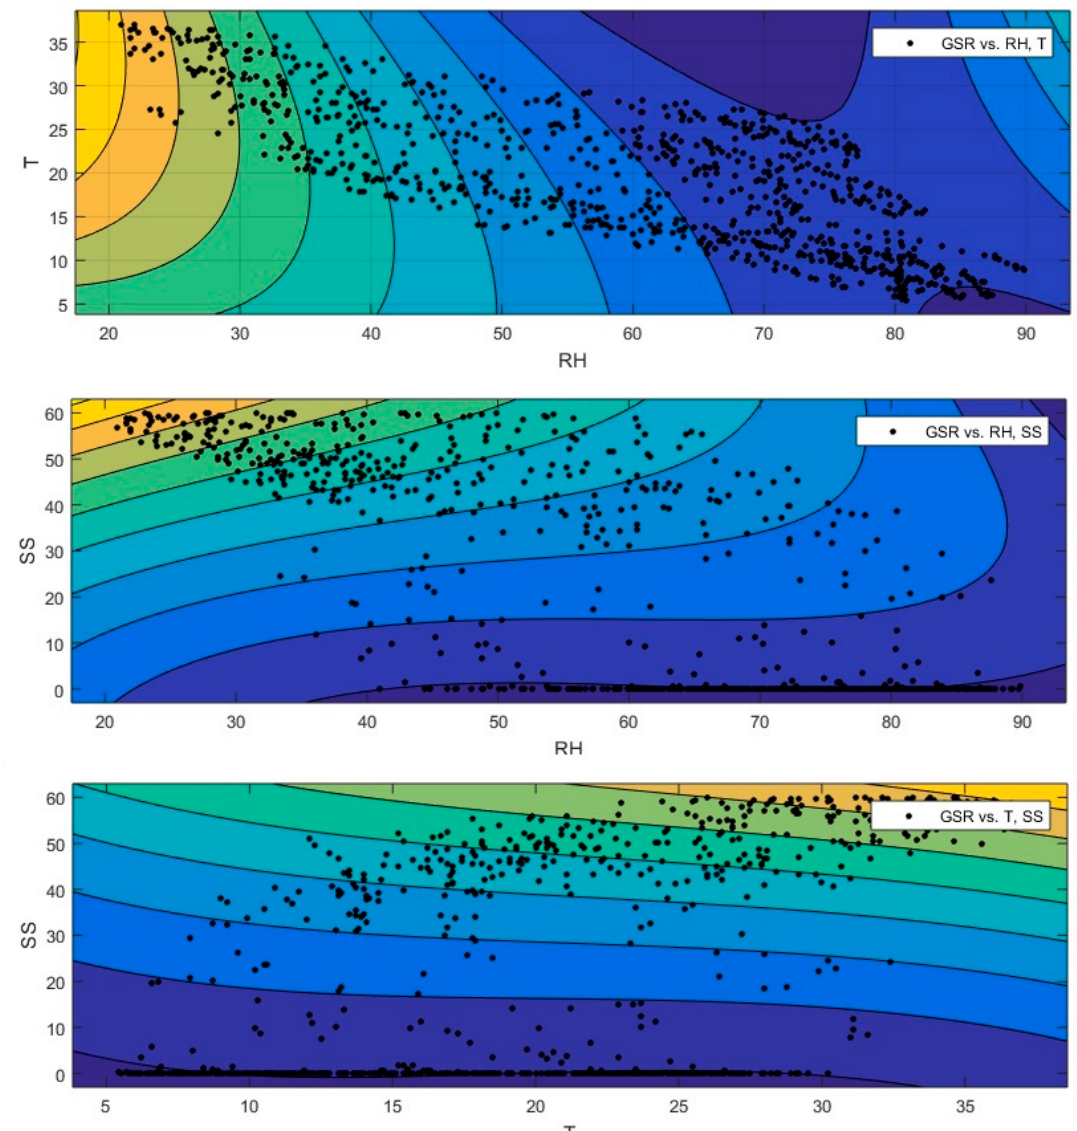
Figure 10. The response surface plot of global solar radiation (GSR).